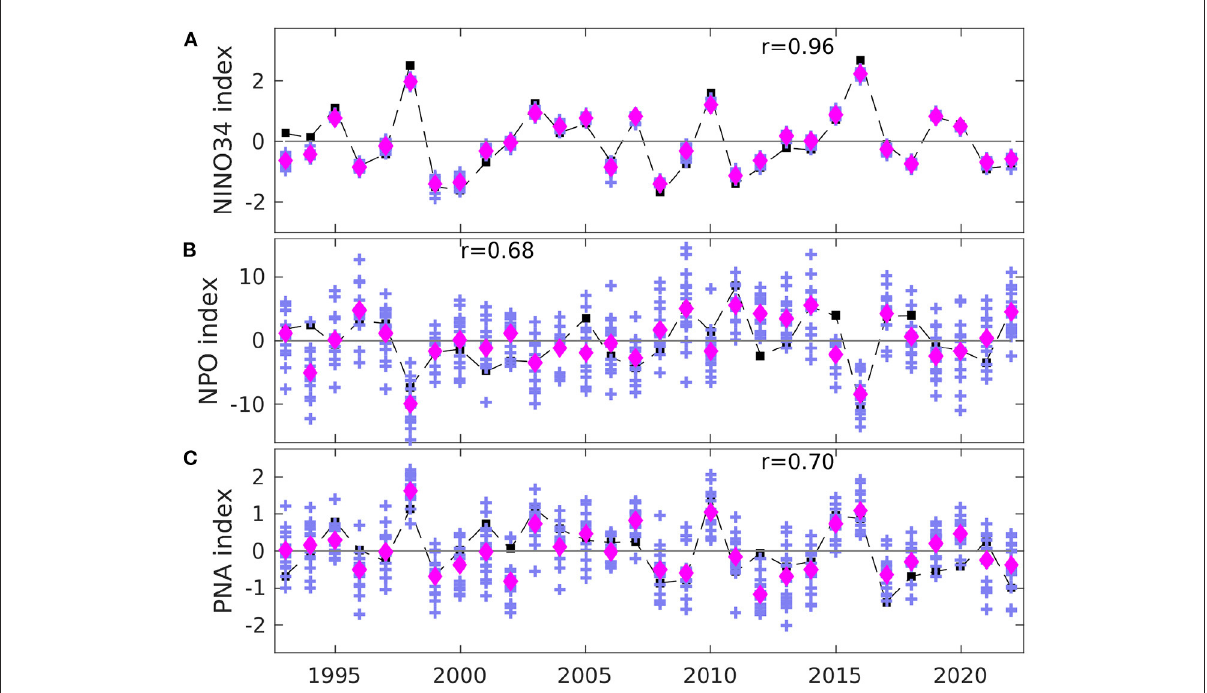
FIGURE7 (A) Time series of the DJF NINO34 anomalies from OISST V2 (black square) and SPEAR’s SRF (magenta diamond for ensemble mean, plus signs for each ensemble member) during 1992–2022. Panels (B) and (C) are the same plot as (A) but for the NPO and PNA index,